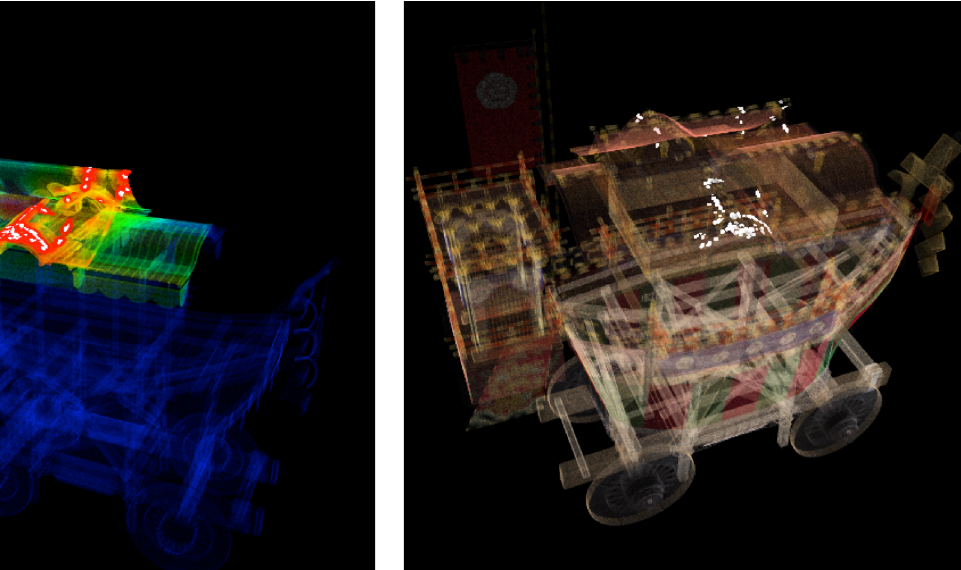
Figure 11. See-through collision visualization of the Ofune- hoko float without showing the point cloud of the street.